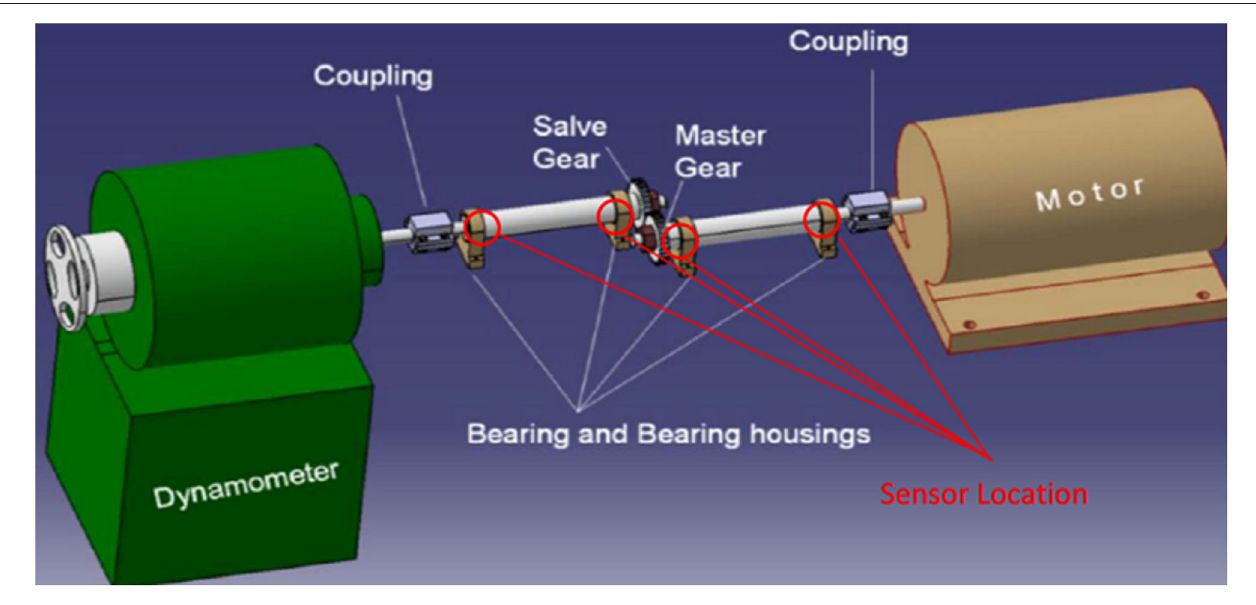
FIGURE 3 | CAD rendering of drive system and bearing